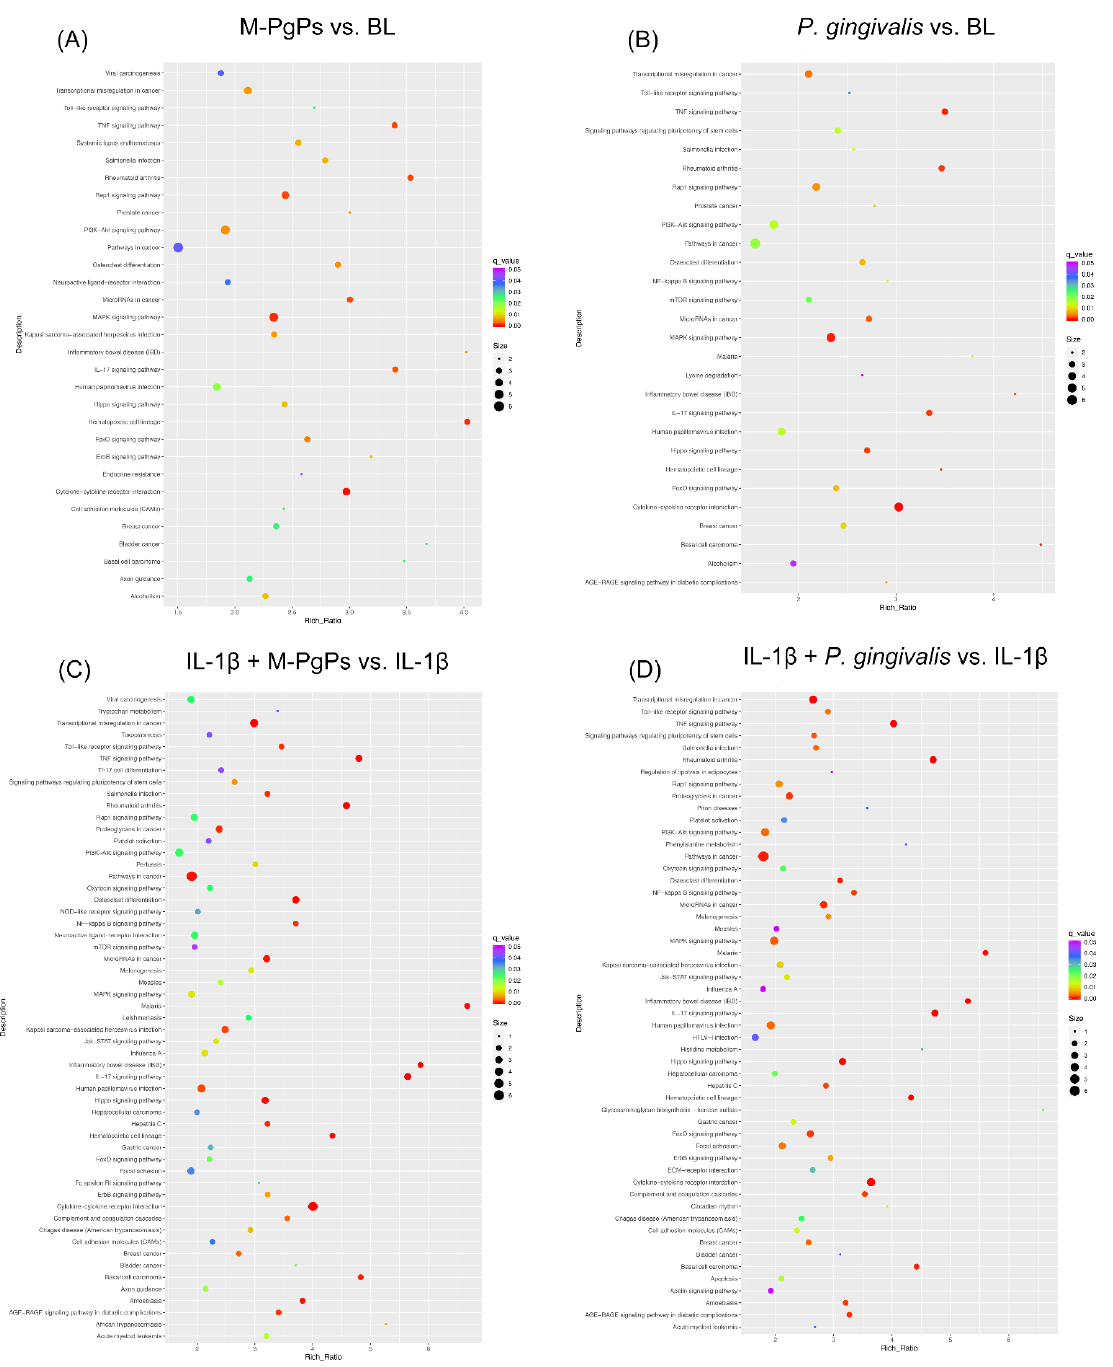
Figure 3. KEGG pathway enrichment analysis of DEGs in different comparison groups. M-PgPs vs. BL ( A ); P. gingivalis vs. BL ( B ); IL-1 β + M-PgPs vs. IL-1 β ( C ); and IL-1 β + P. gingivalis vs. IL-1 β ( D ). Rich Ratio is shown on the x axis. KEGG pathway names are shown on the y axis. Size of the dots represents numbers of genes enriched in the term. Color of the dots represents q value. Samples for RNA-Seq were obtained from three independent